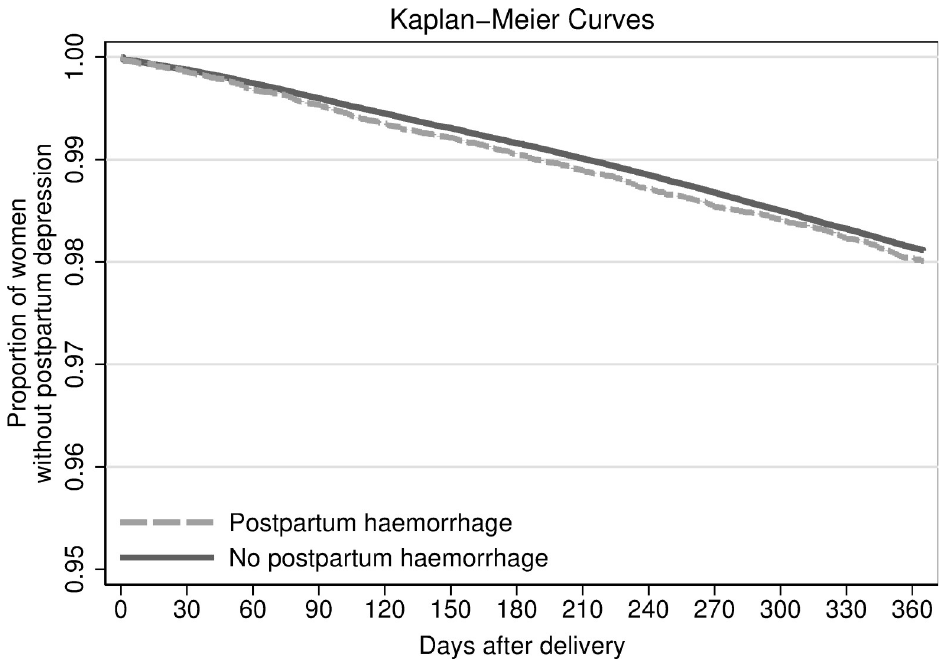
Fig 2. Kaplan-Meier curves for postpartum depression by postpartum hemorrhage exposure status and by mode of delivery.